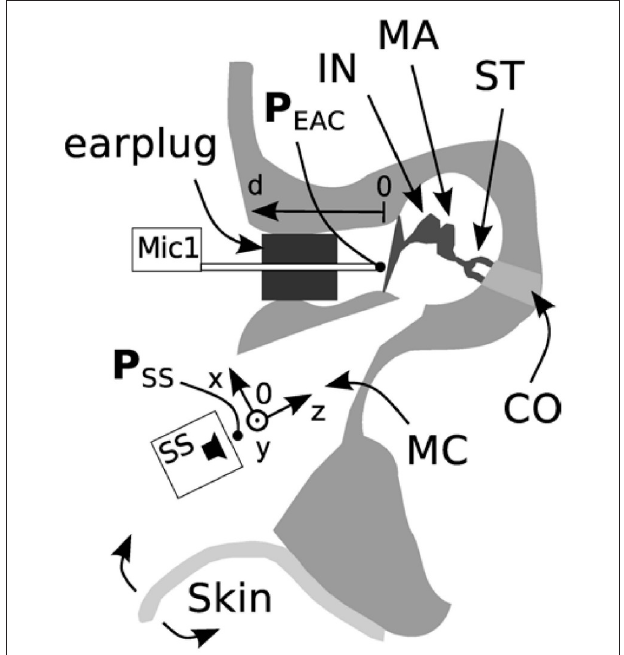
FIGURE 2 | Specimen preparation and measurement setup (axial cut, top is frontal). The pressure in the ear canal, P EAC , was measured after a mastoidectomy with an intact ossicular chain (IN, incus; MA, malleus; ST, stapes) and tympanic membrane. The external auditory canal (EAC) was closed using a foam earplug. The loudspeaker ER-2 (SS) was placed initially at position 0 and displaced along the x, y, and z axes. The tip of probe microphone was initially positioned 2 mm from the tympanic membrane and displaced along the d-axis (Mic1). The skin flap was used to close the mastoid cavity (MC). CO,